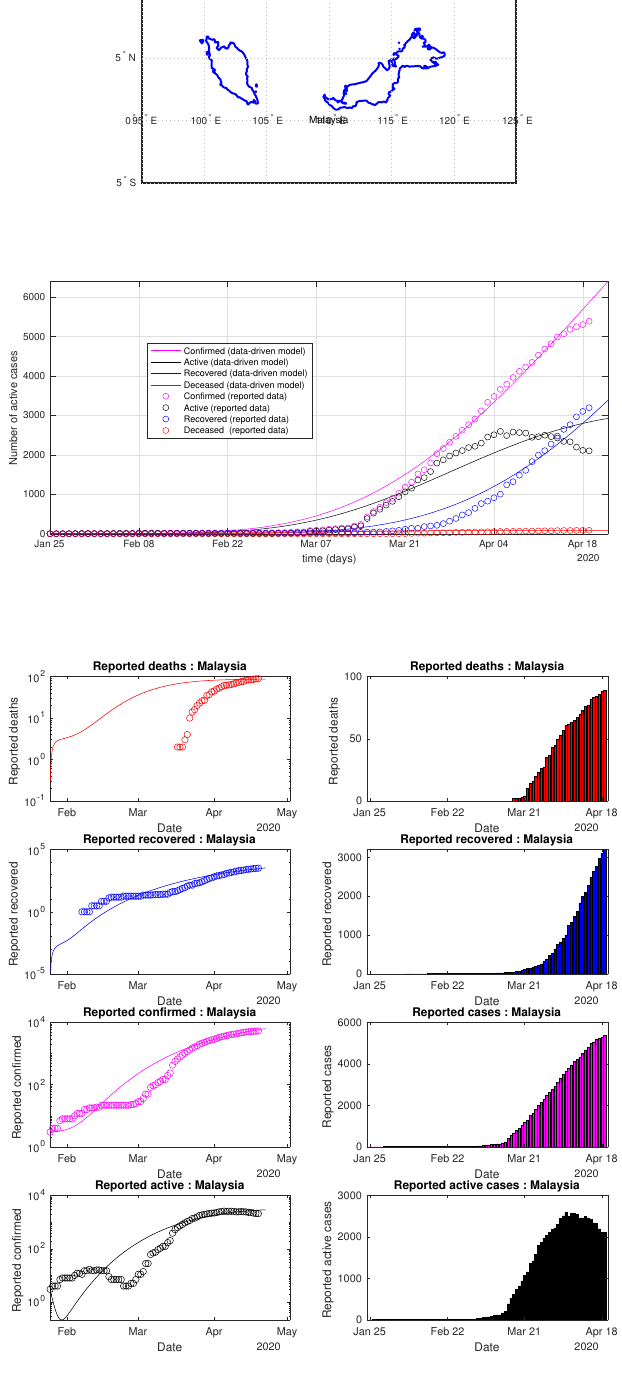
Figure 38. Malaysia: data of active, recovered, deceased (in circle or bar) vs. model of active, recovered, deceased over time. Tracking the number of active cases. Predictive analytics for the next couple